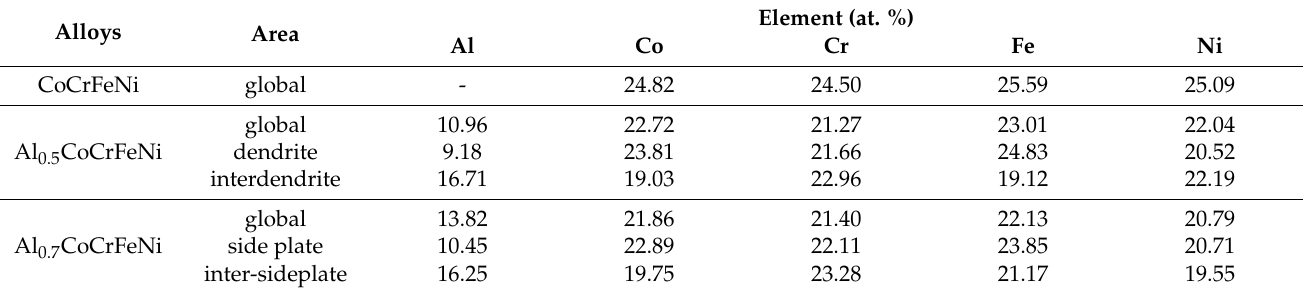
Table 3. Chemical composition of obtained alloys, EDX analysis.